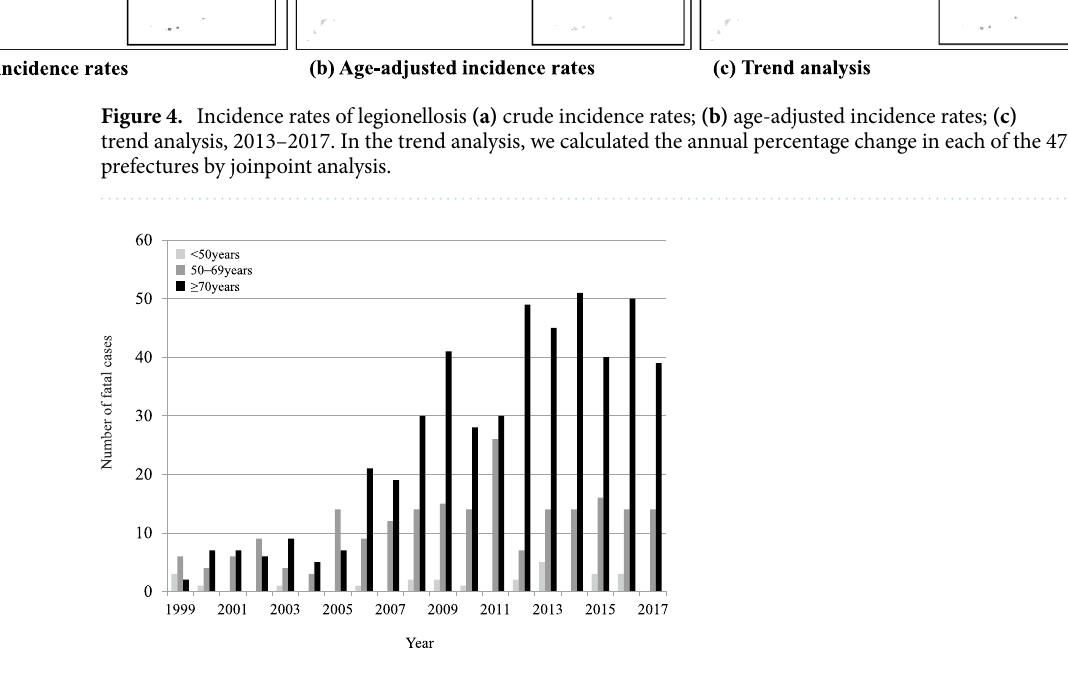
Figure 5. Trends in the number of fatal cases by age category for legionellosis in Japan, 1999–2017. The figure shows the trends in the number of fatal cases by age group and an increase in incidence especially in those aged over 70 years from 1999 to